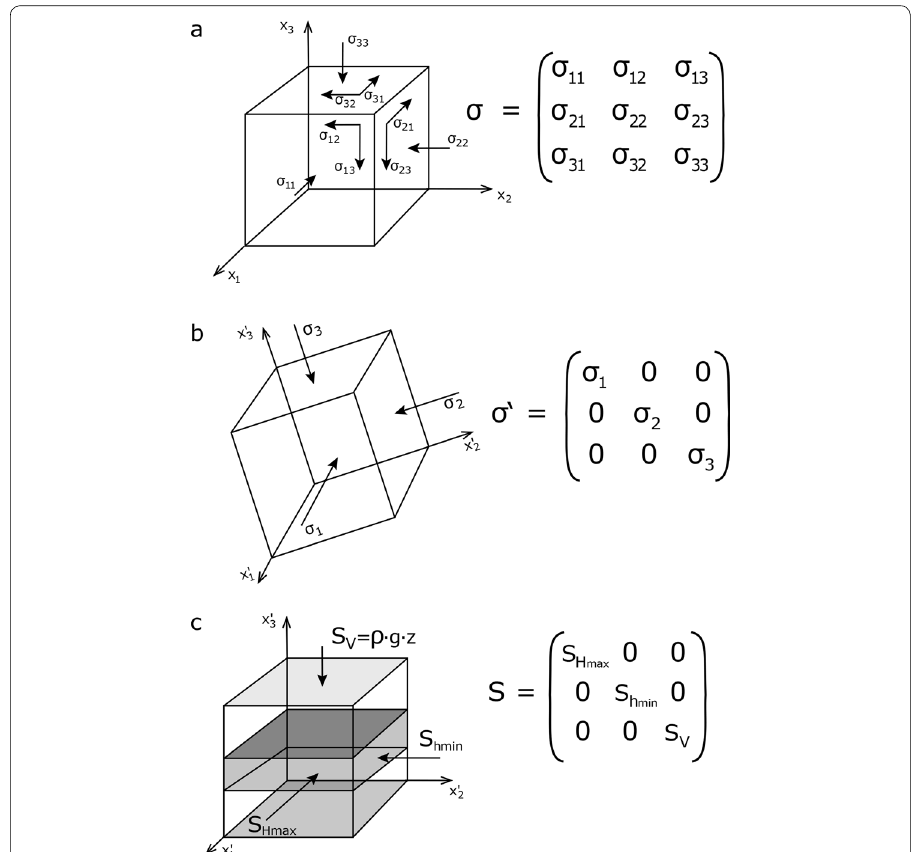
Fig. 1 Explanation of the stress tensor. a The nine components of the stress tensor describe the stress state at an arbitrary point and enable calculation of the stress vector on any surface through that point. To describe the stress tensor components, an infinitely small cube with unit surfaces is used. b Due to the conservation of momentum (no rotation), the stress tensor is symmetric, and thus a coordinate system exists where shear stresses vanish along the faces of the cube. In this principal axis system, the remaining three stresses are the principal stresses. c Assuming that the vertical stress in the Earth’s crust S V = ρ · g · z ( g is gravitational acceleration, ρ is the rock density, z is the depth below surface) is a principal stress, S hmin and S Hmax are also principal stresses. This so-called reduced stress tensor is fully determined by four components: the S Hmax orientation and the magnitudes of S V , S Hmax , and S